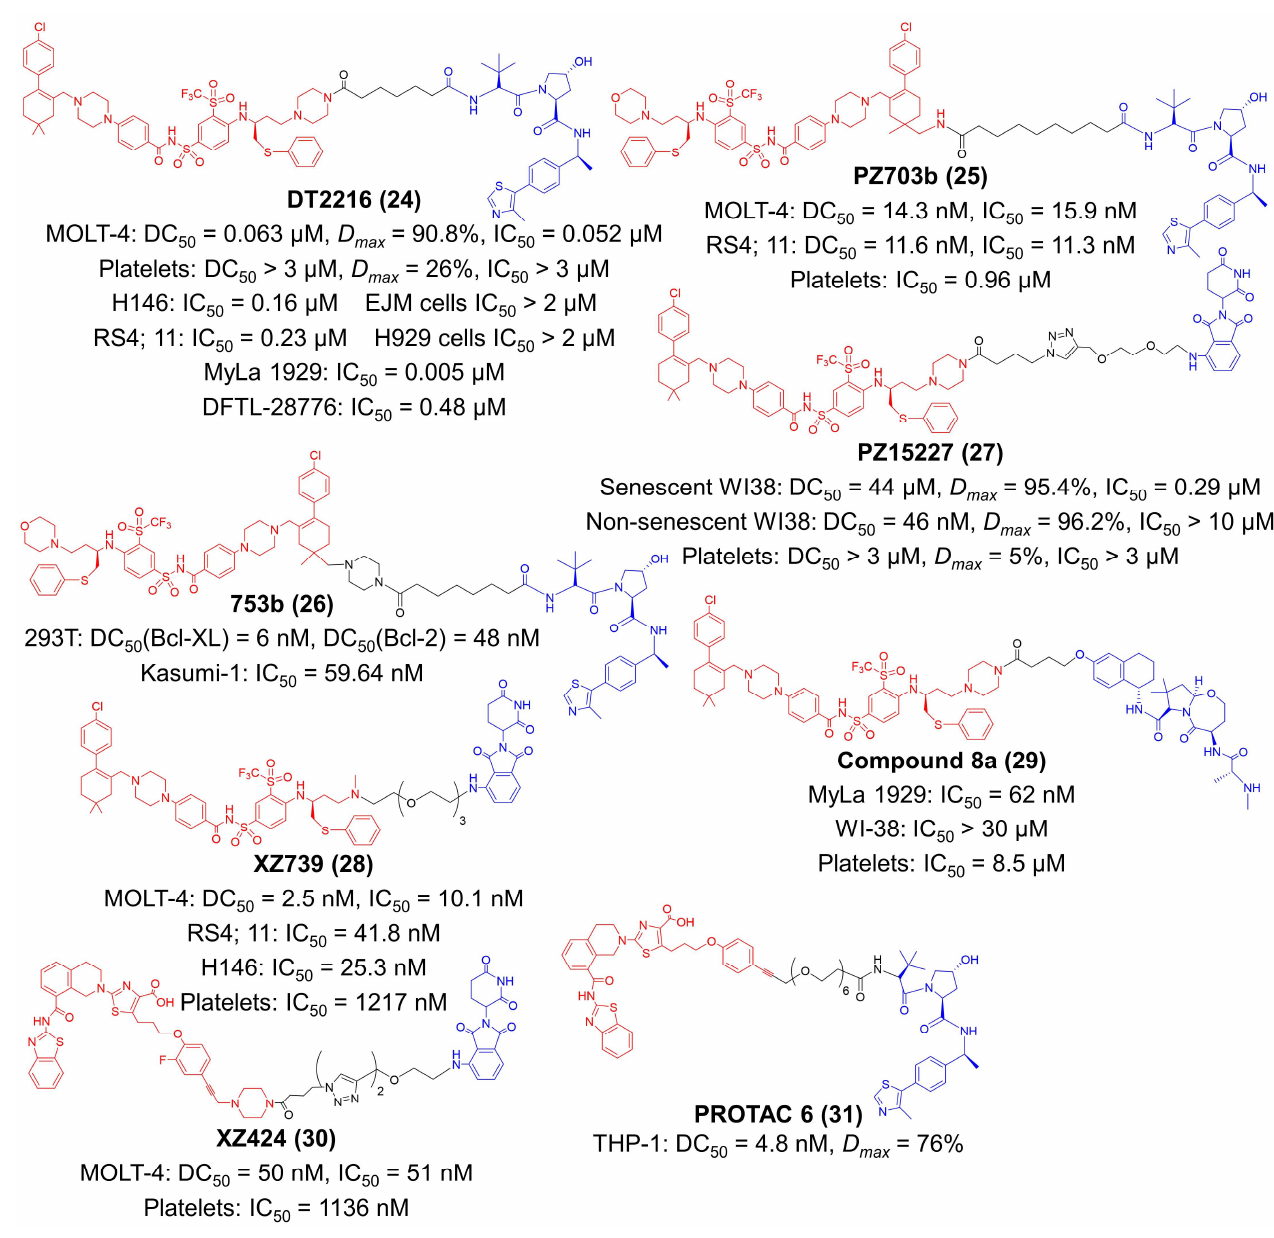
Figure 5. The chemical structures of representative PROTACs target the Bcl-2 family. DC 50 —half- maximal degradation concentration; Dmax —maximum degradation; IC 50 —half-maximal inhibition concentration.